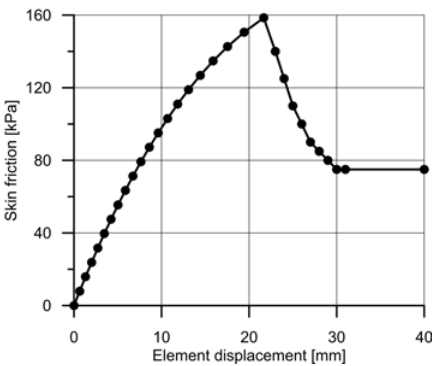
Figure 11. Assembled load transfer